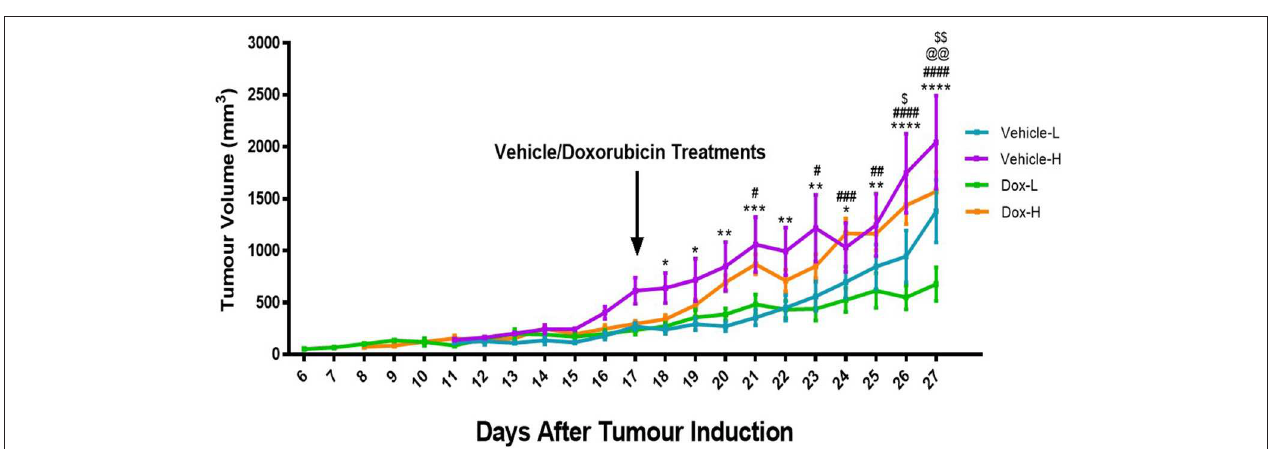
FIGURE 5 | Differences in tumor volume for the vehicle control and doxorubicin treatment groups on LFD and HFD. Results are presented as mean ± SEM ( n = 10 per group). Three-way ANOVA with Fisher’s LSD post hoc correction was applied and p < 0.05 was considered as statistically significant. * p < 0.05, ** p < 0.01, *** p < 0.001, and **** p < 0.0001. # p < 0.05, ## p < 0.01, ### p < 0.001, and #### p < 0.0001, $ p < 0.05. * Vehicle-L vs. Vehicle-H, # Dox-L vs. Dox-H, @ Vehicle-L vs. Dox-L, $ Vehicle-H vs. Dox-H. @@ p < 0.01, $$ p < 0.01.